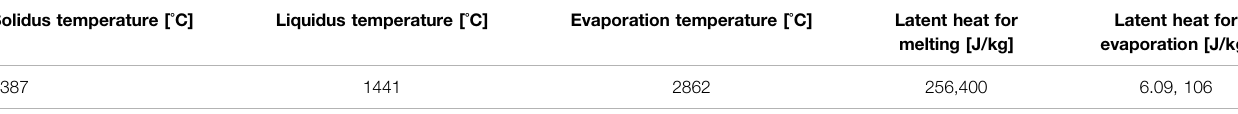
TABLE 3 | Thermodynamic material properties for 18Ni300 calculated using the TCFE10 database 1 . Solidus temperature [ ° C]